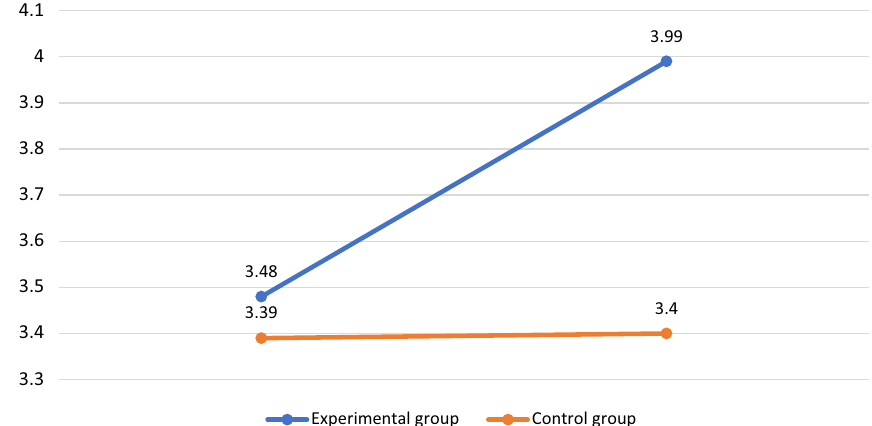
Fig. 2 Teenage EFL students’ intercultural